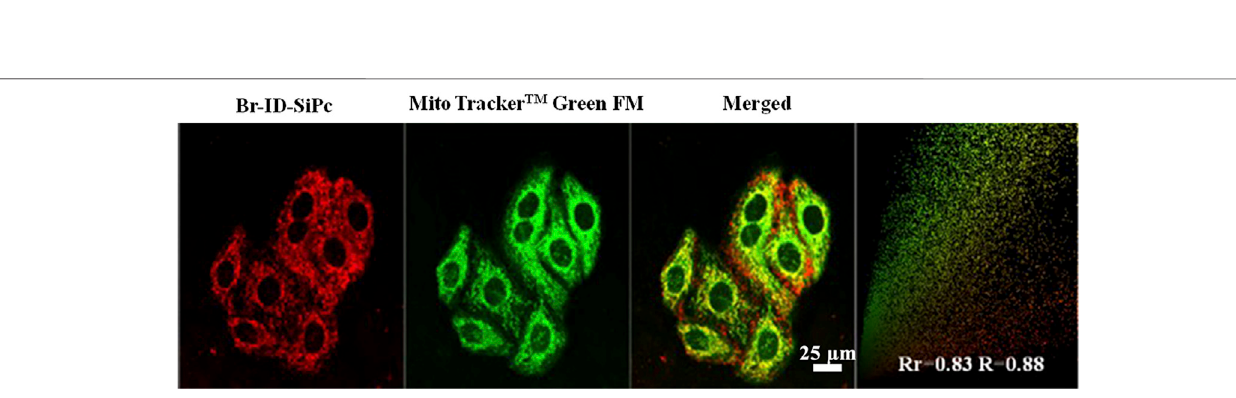
FIGURE 3 | Confocal microscopy fl uorescence images of HO-8910 cells after being incubation with Br-ID-SiPc for 4 h ( λ ex = 860 nm, λ em = 650 – 750 nm).